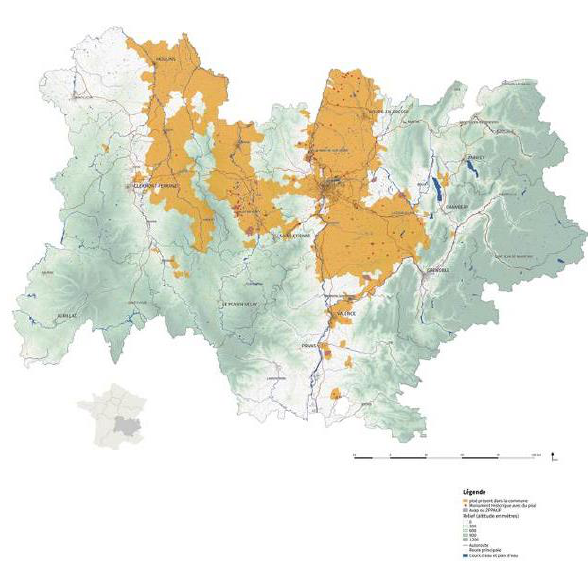
Figure 1. State of the inventory of architectures in rammed earth in 2018 © CRAterre 2018.